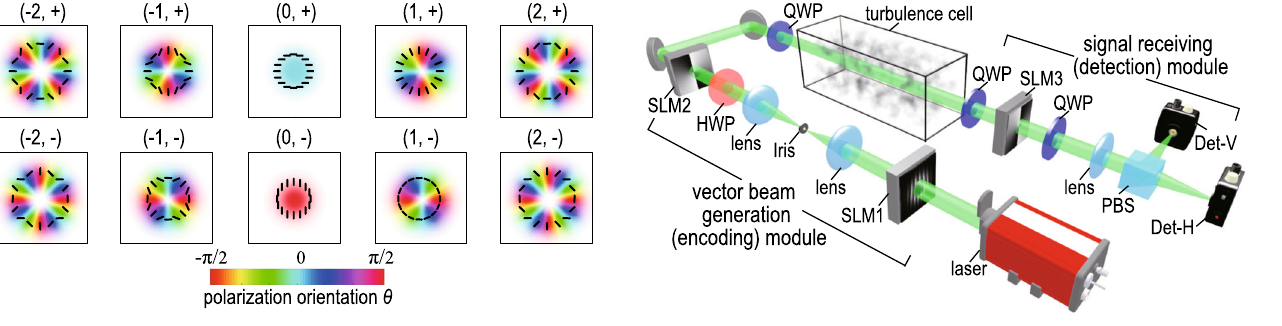
Fig. 3 Schematics of the experiment. The schematic diagram of the proof- of-principle experiment including a vector beam generation module, a controllable turbulence cell, and a signal detection module. SLM spatial light modulator, HWP half-wave plate, QWP quarter-wave plate, PBS polarizing beam splitter, Det detector.